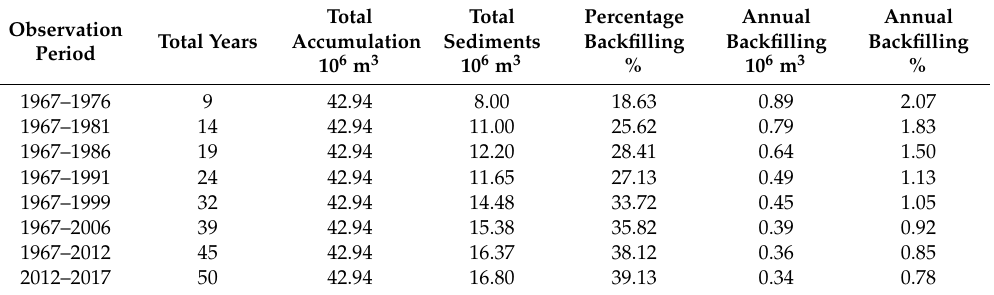
Table 8. Data of Potpec reservoir filling and percentage of backfill since the beginning of measurements with respect to a free volume of the reservoir of 42.94 10 6 m 3 .